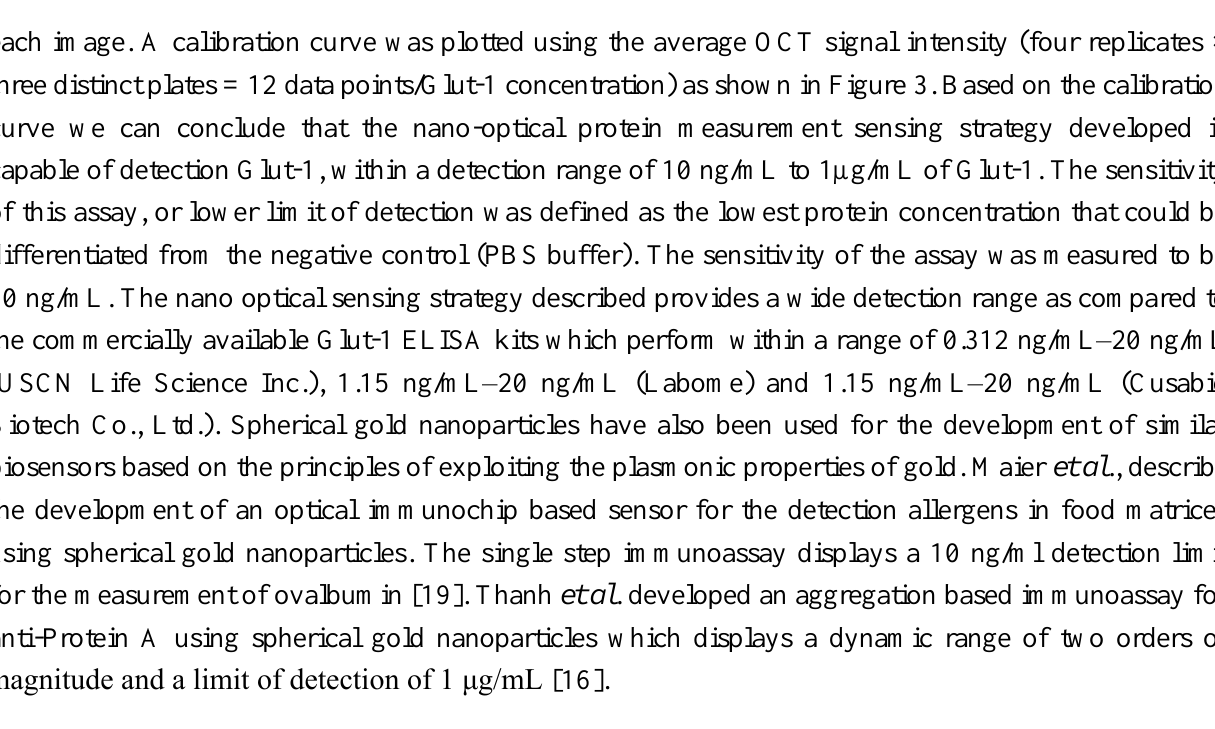
Figure 2. Background subtracted OCT images of well plates containing anti-Glut-1 tagged GNRs attached to Glut-1 protein suspended in PBS.